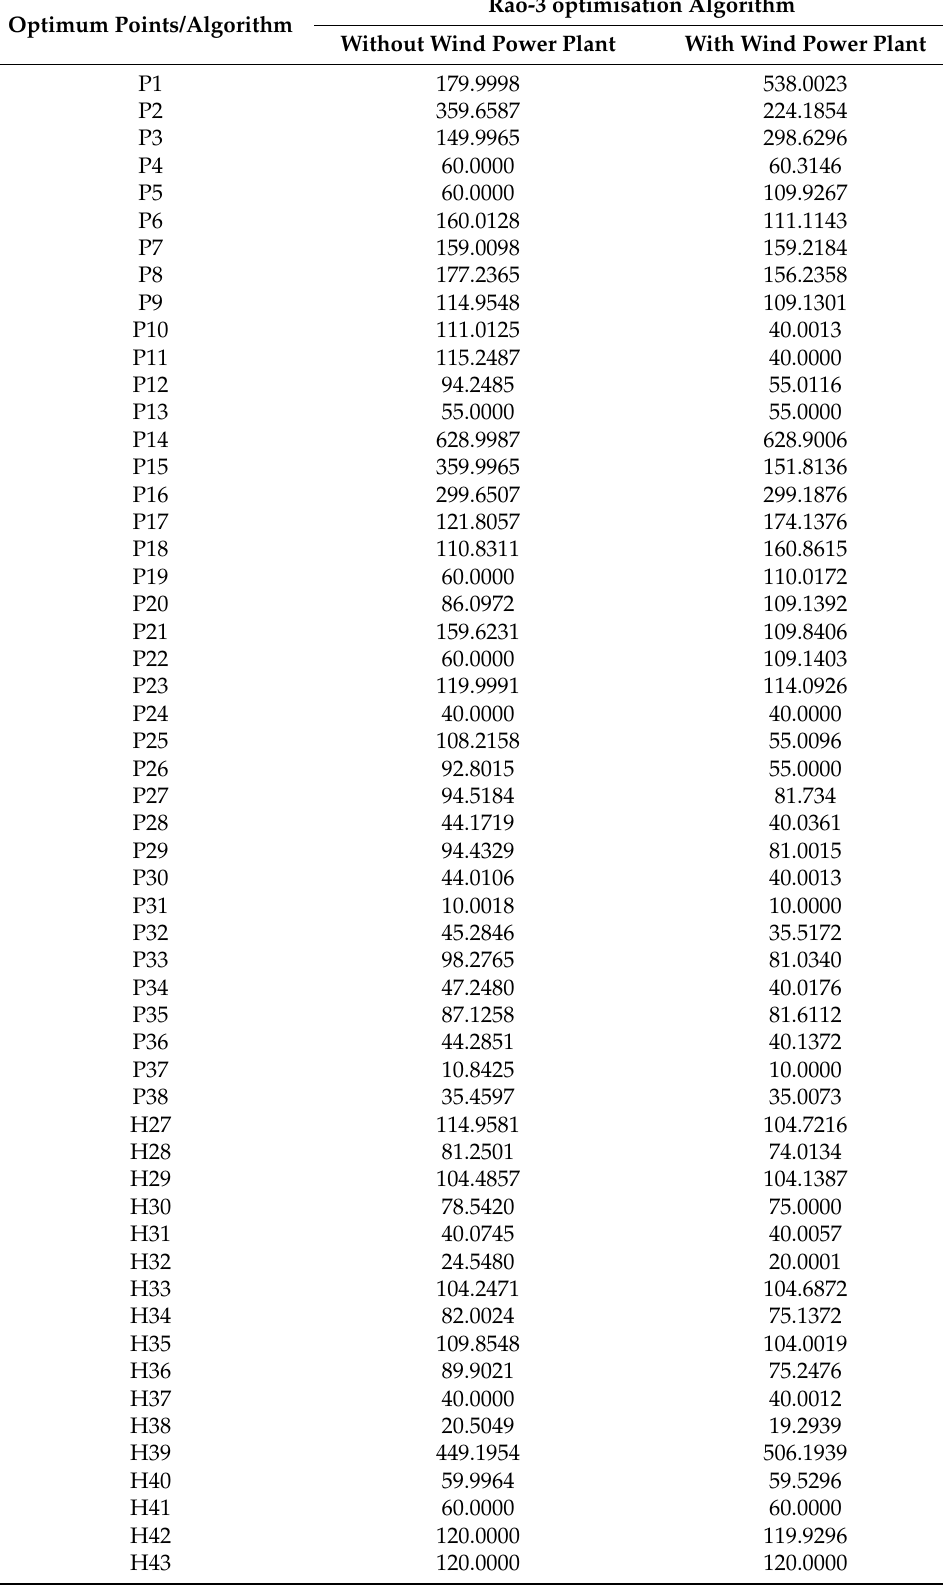
Table 3. Optimal allocation of power and heat generation considering VPL effect and